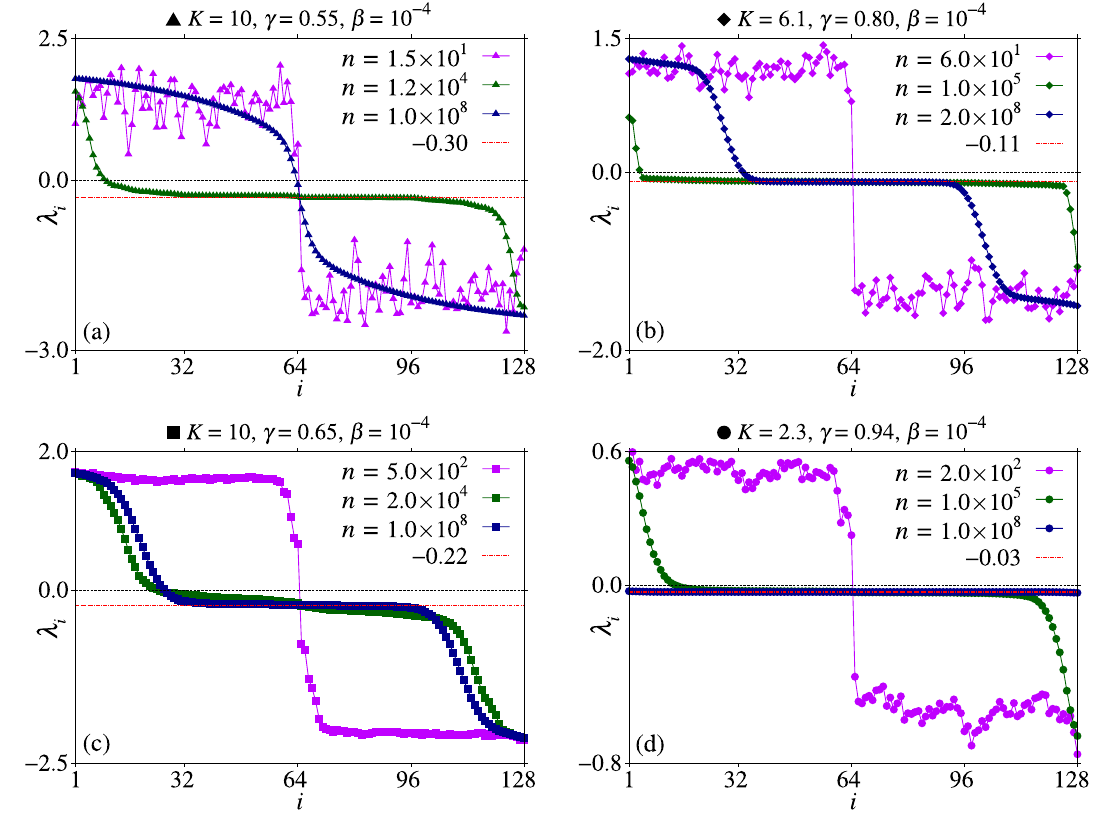
Figure 6. The spectrum of FTLEs for N = 64 and β = 10 − 4 by using the same parametric combinations from Figs. 2 and 4 and different values for the iteration time n . The symbols used correspond to the symbols from Fig. 1. The red dashed-dotted lines indicate the value of the FTLE (cid:31) obtained for the uncoupled